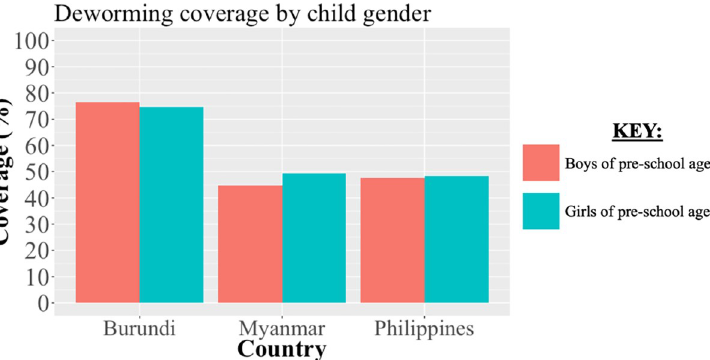
Fig 5. Comparison of national-level deworming coverage amongst girls and boys of pre-school age estimated by DHS data in study countries. We estimated the national-level deworming coverage using maternally-reported child deworming status from DHS stratified by child gender (girls and boys). We compared the estimated coverage by gender using a base recall period of 6 months in Burundi, Myanmar, and the Philippines as based on the DHS question